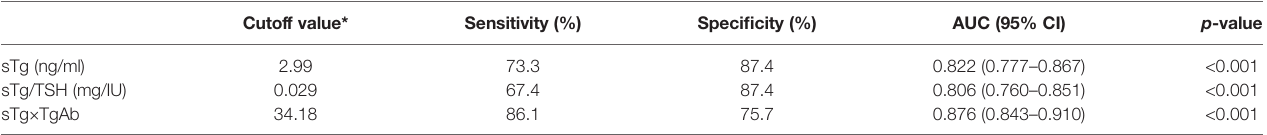
TABLE 2 | Cutoff values* for predictors of successful 131 I ablation with sensibility and speci fi city.